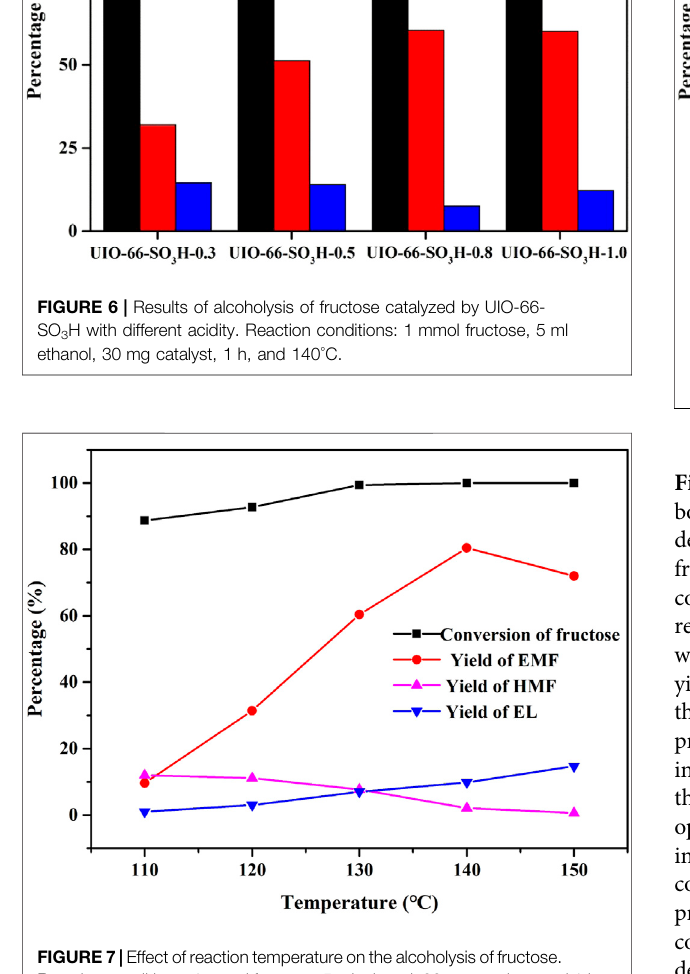
FIGURE7| Effectofreactiontemperatureonthealcoholysisoffructose. Reaction conditions: 1 mmol fructose, 5 ml ethanol, 30 mg catalyst, and 1 h.